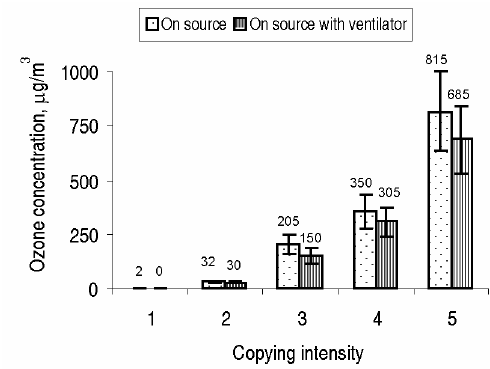
Fig 6. Distribution of ozone at different regimes of copy- ing process intensity in ventilated and unventilated room